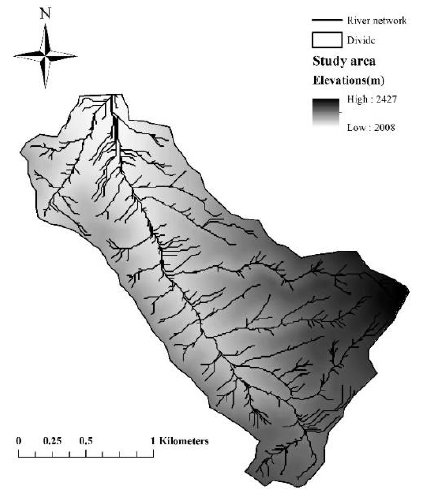
Figure 1. Borders of the study area with its main tributaries. DEM files with a spatial resolution of 12.5 m (from Advanced Land Observation Satel- lite (ALOS)) and other required data such as rainfall records, temperature, evaporation, and curve number (CN) values, were provided from the local Natural Resources